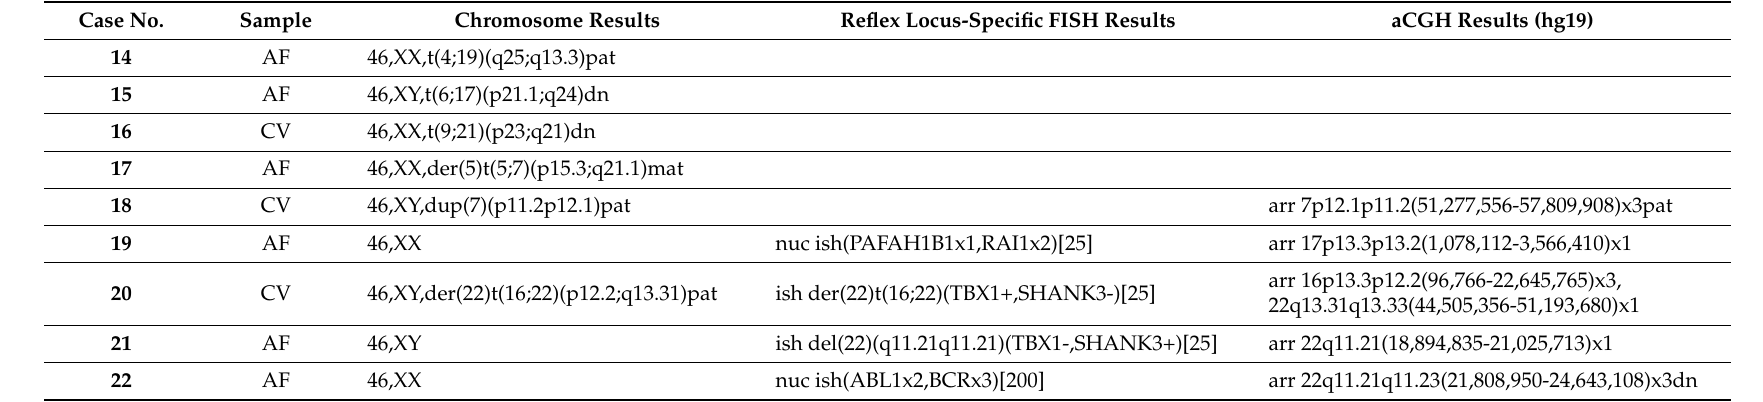
Table 3. Structural chromosomal abnormalities and pathogenic copy number